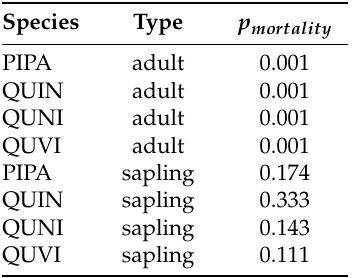
Table A20. Species mortality parameters.